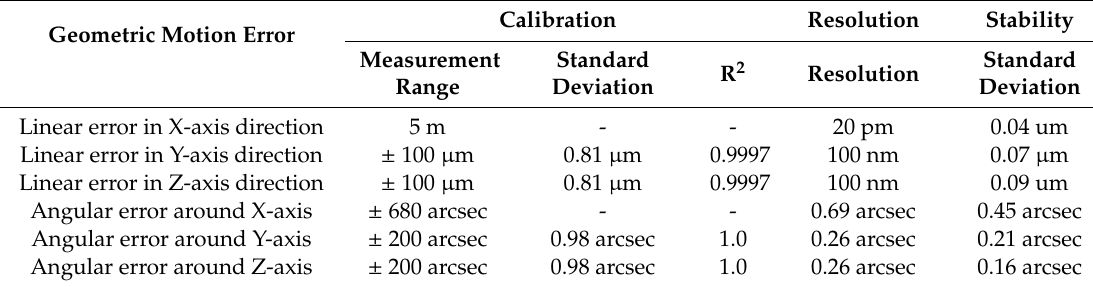
Table 2. Experimental results of calibration, resolution, and